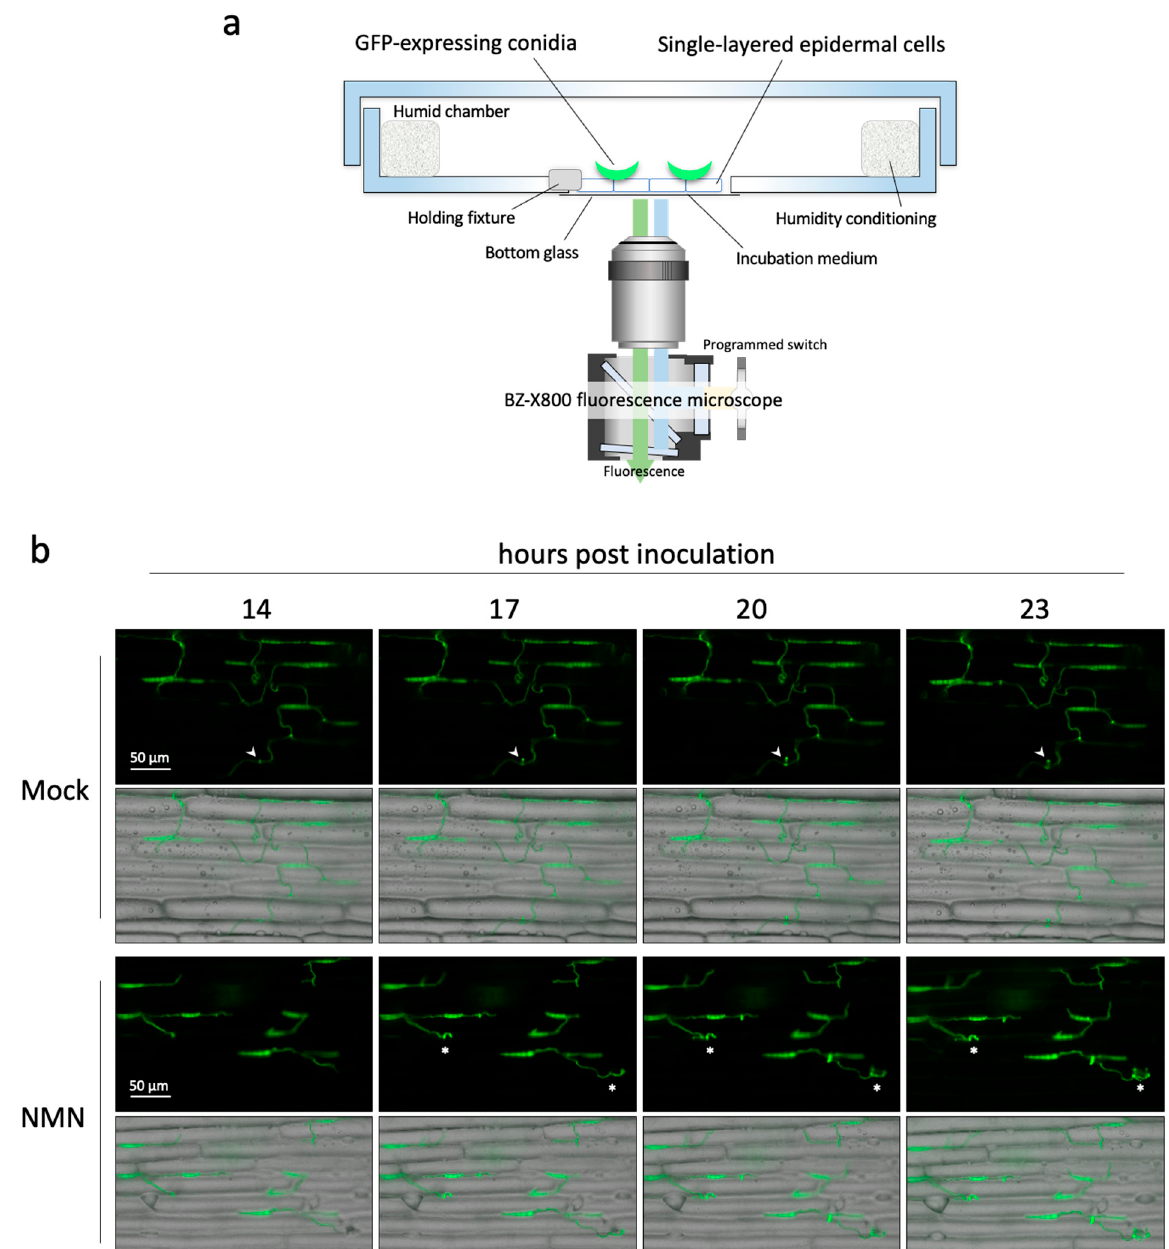
Figure 5. Real-time imaging of infection behavior of Fusarium graminearum on coleoptile epidermal cells treated with 500 ppm NMN. ( a ) Real-time monitoring system for infection behavior of F. graminearum . ( b ) Three hours after inoculation and thereafter, the fluorescence was automatically photographed every 30 min. The real-time imaging was supplemented as video files (Video S1–S4). The arrowheads indicate an appressorium-like structure. The asterisks indicate winding hy- phae.